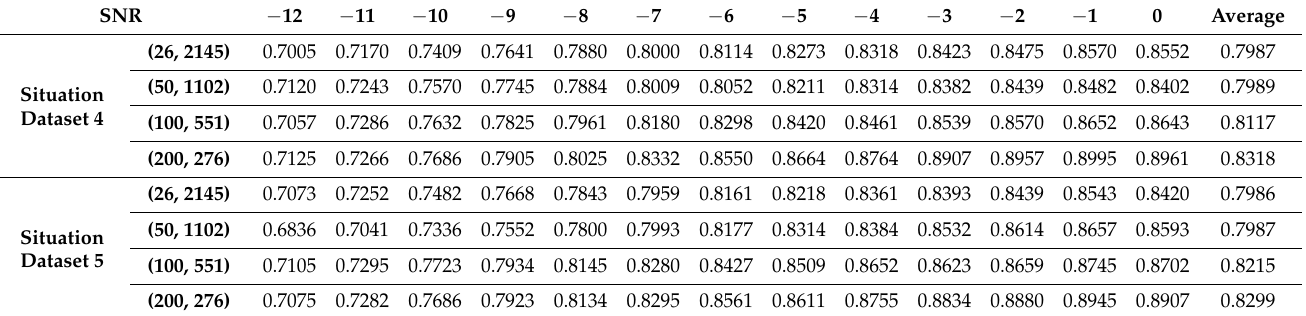
Table 9. Semi-supervised classification results with the datasets without self-paced data augmentation.